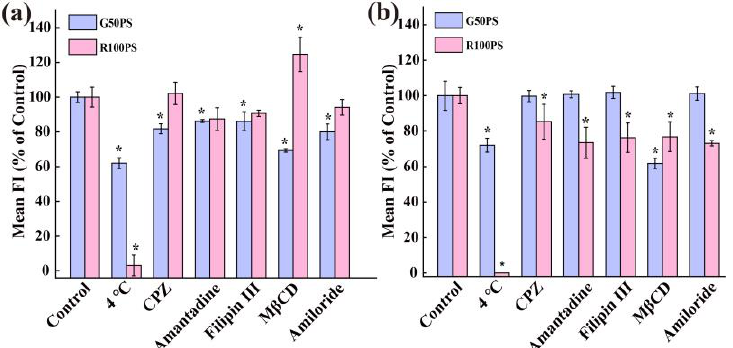
Figure 4. Mechanisms involved in the uptake process of PS NPs by A549 cells (a) and BEAS-2B cells (b) . *P < 0.05 compared with the control, (n = 3). ( b ) * p < 0.05 compared with the control, (n =